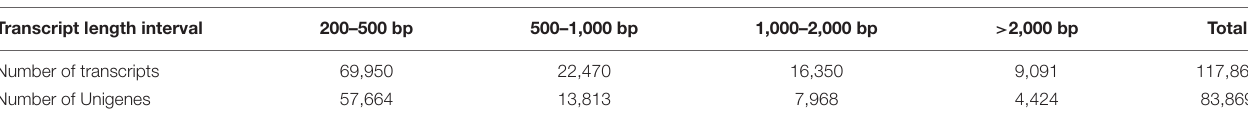
TABLE 2 | Length distribution of transcripts and